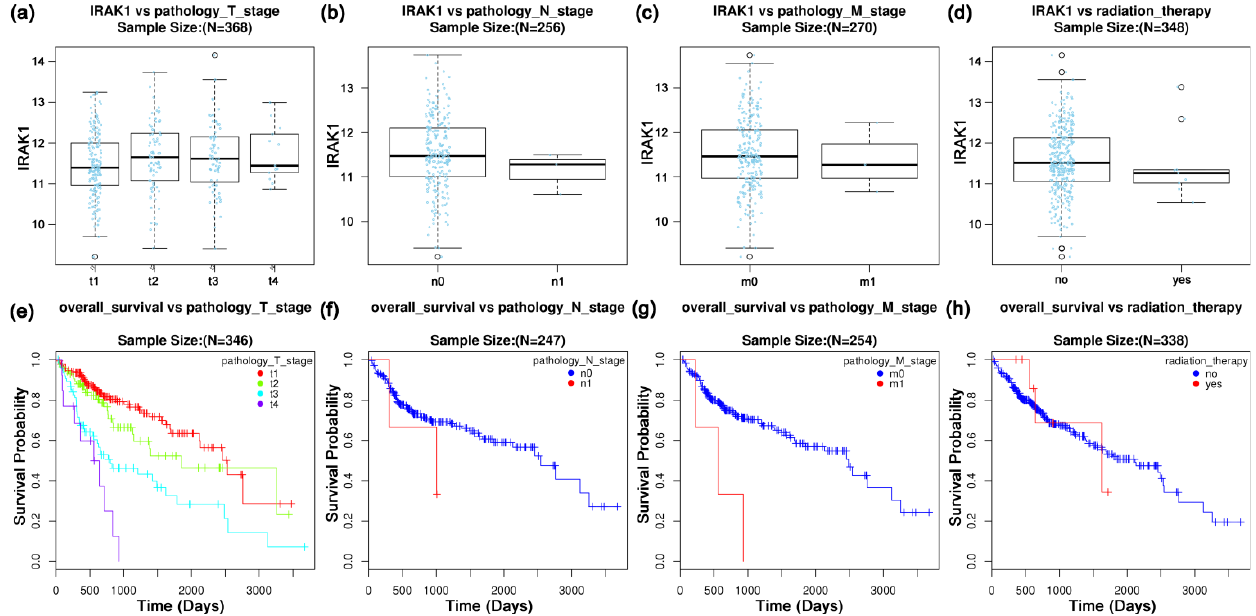
Figure 3. Variation of IRAK1 expression and overall survival of hepatocellular carcinoma based on pathology TNM stages and radiation therapy status. ( a ) IRAK1 vs. T stage ( p = 0.1675, Kruskal-Wallis test); ( b ) IRAK1 vs. N stage ( p = 0.2957, Wilcox test); ( c ) IRAK1 vs. M stage ( p = 0.6619, Wilcox test); ( d ) IRAK1 vs. radiation therapy ( p = 0.3961, Wilcox test); ( e ) overall survival vs. T stage ( p = 0.1269); ( f ) overall survival vs. N stage ( p = 0.2542); ( g ) overall survival vs. M stage ( p = 0.0106); ( h ) overall survival vs. radiation therapy status ( p = 0.9553). The statistics for panels ( e – h ) were Cox regression test.